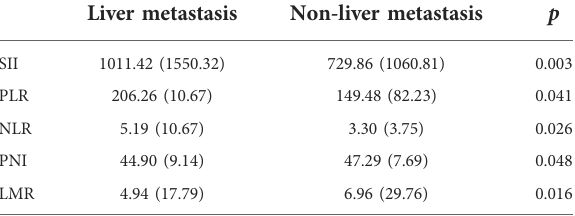
TABLE 3 Relationship between in fl ammation markers and liver